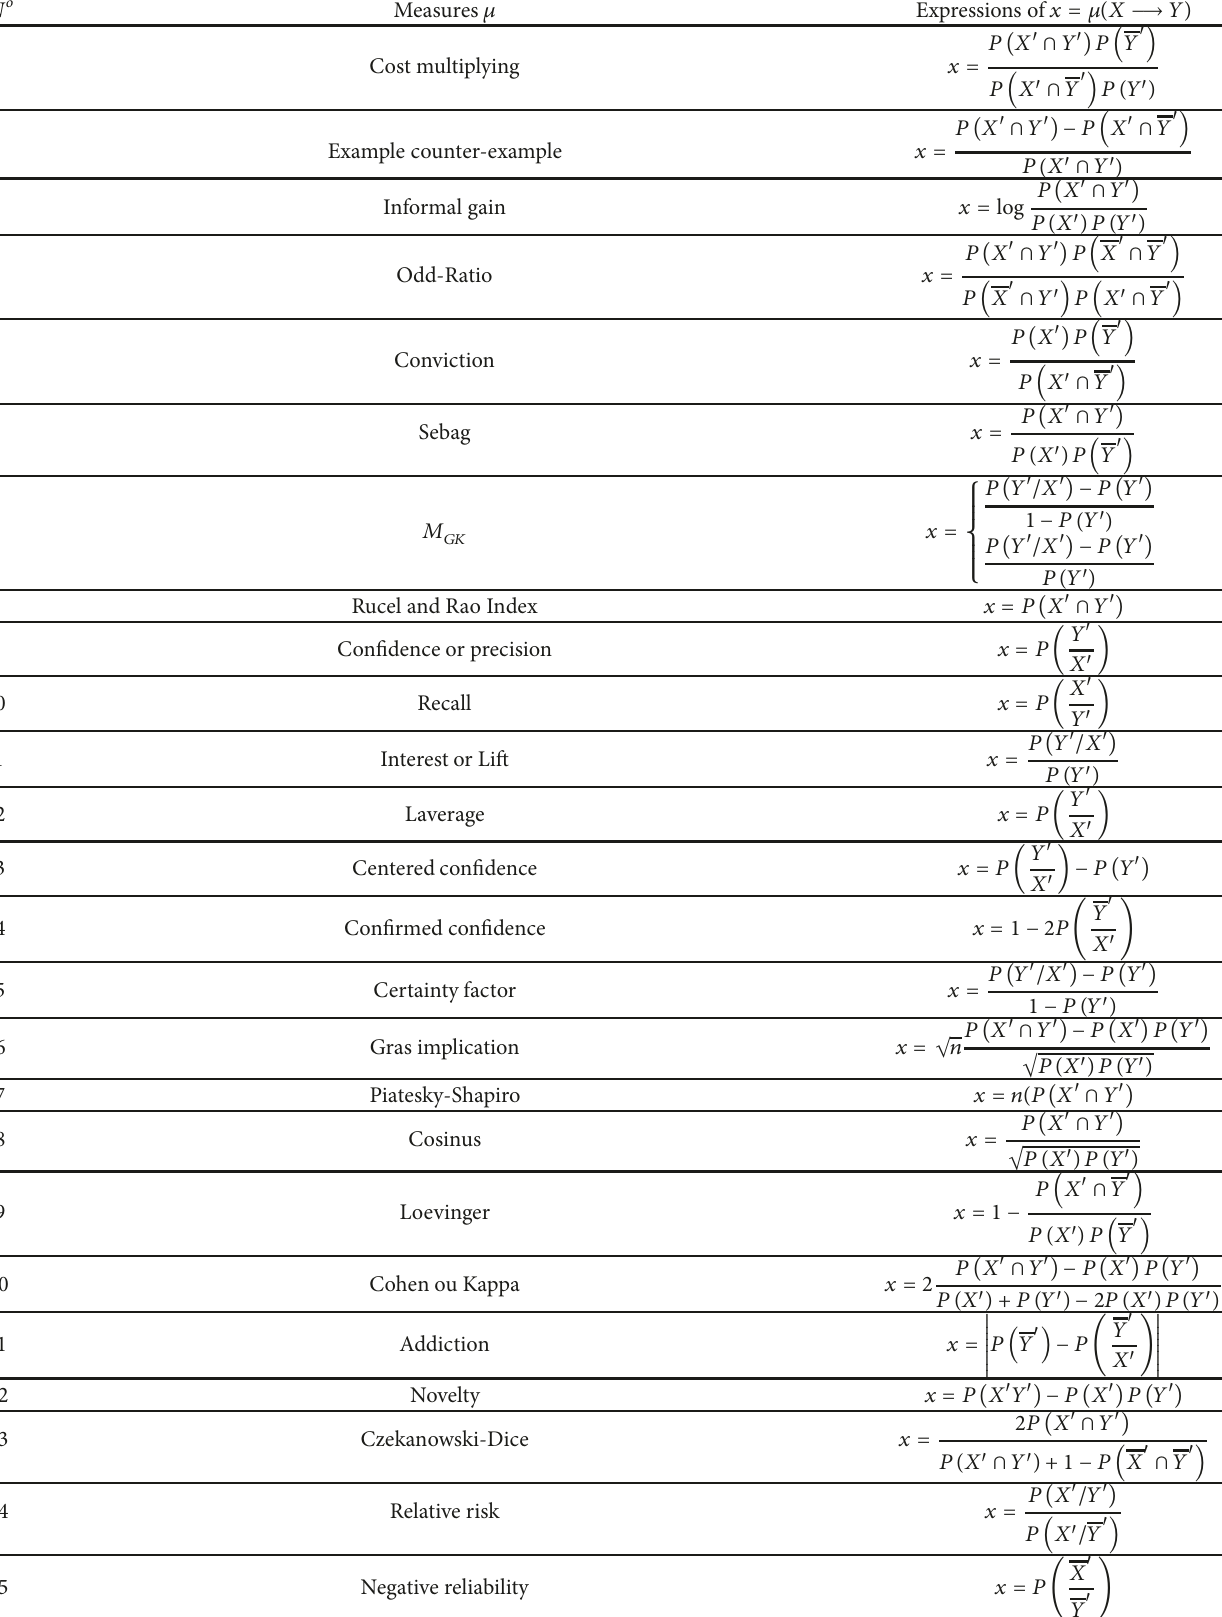
Table 1: Probabilistic quality measures of